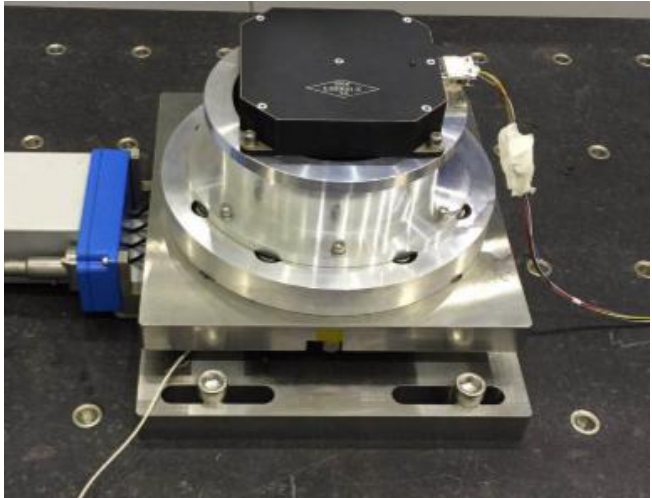
Figure 3. Testing flywheel perturbation.